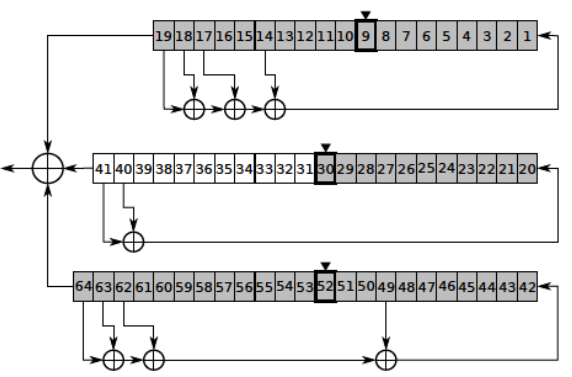
Figure 1: The A5/1 generator scheme. The bits which are guessed in Anderson’s attack are greyed